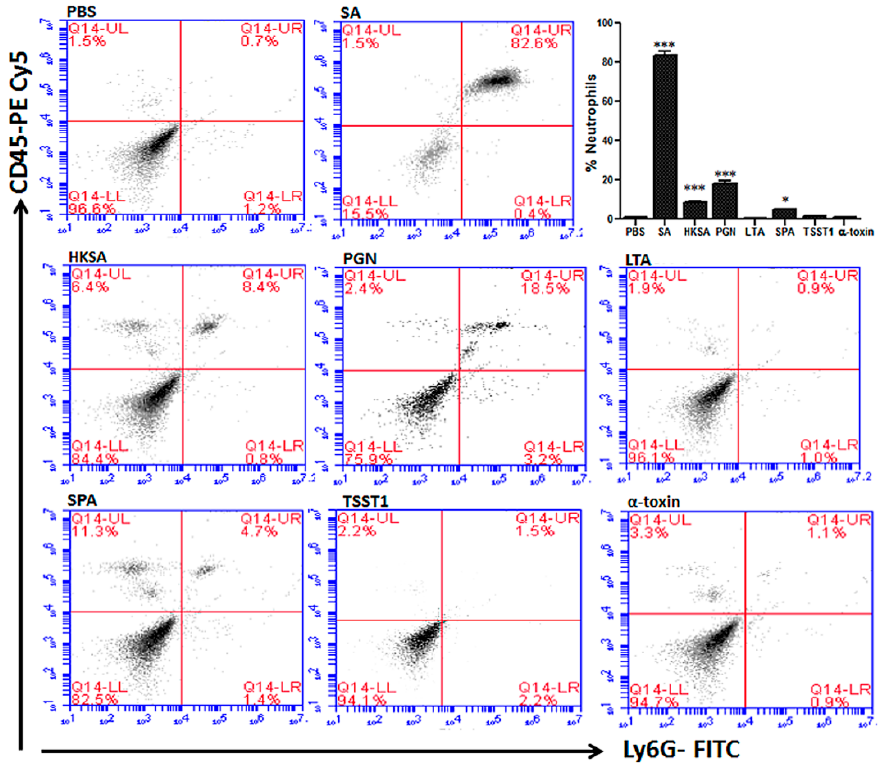
Figure 8. PMN infiltration into mouse retinas following the injection of S. aureus virulence factors. Mouse eyes injected with PBS, S. aureus (SA), heat-killed S. aureus (HKSA), peptidoglycan (PGN),